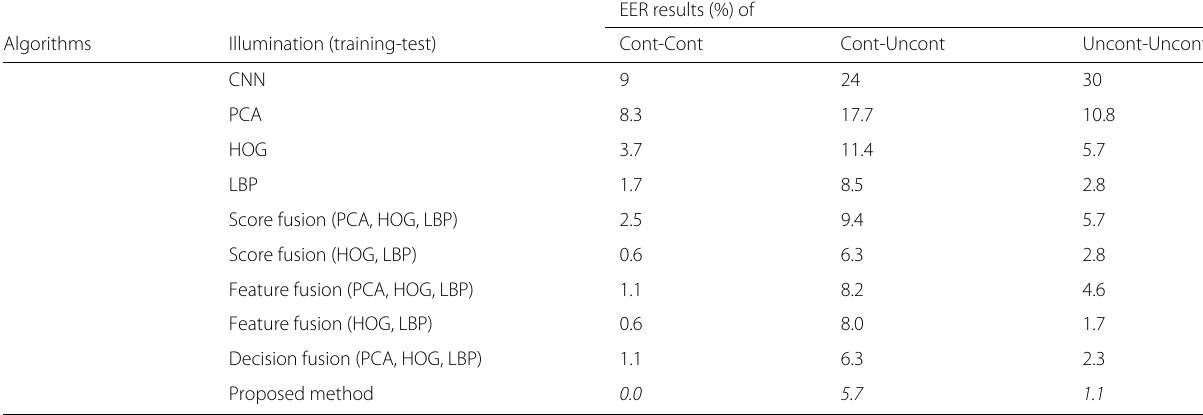
Table 5 EER results of illumination-based experiments for non-twins ( Cont controlled condition, Uncont uncontrolled